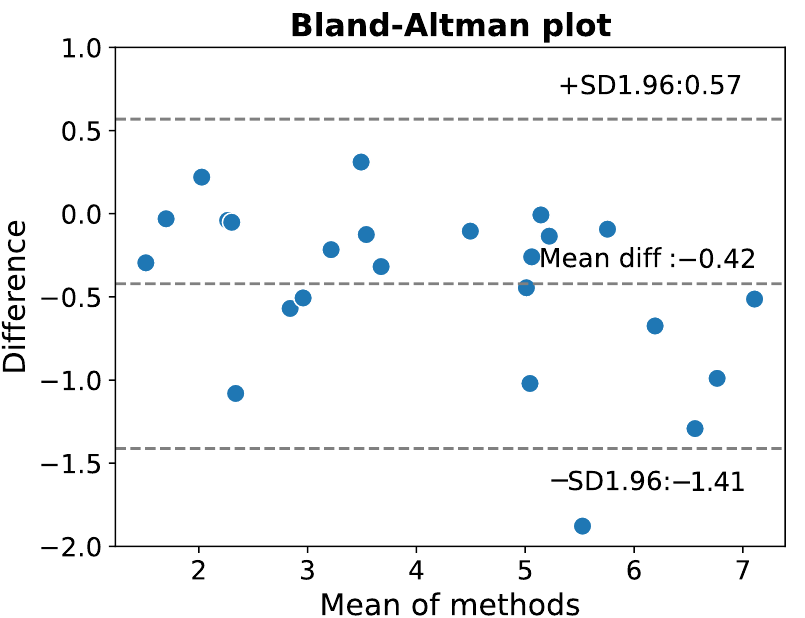
Figure 9. The Bland–Altman difference plot. Here, a 95% confidence interval is assumed for the means of the differences.